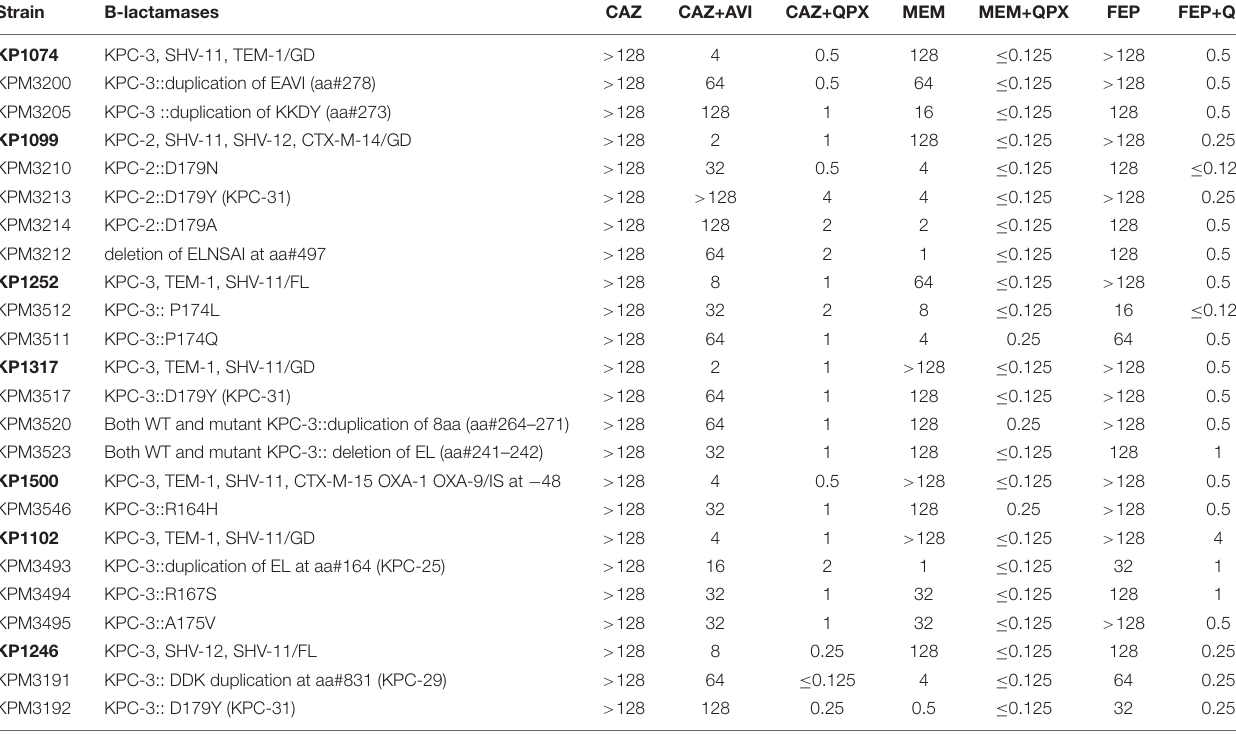
TABLE 6 | The effect of KPC mutations selected with ceftazidime-avibactam on potency of QPX7728 in combination with ceftazidime, meropenem, and cefepime.